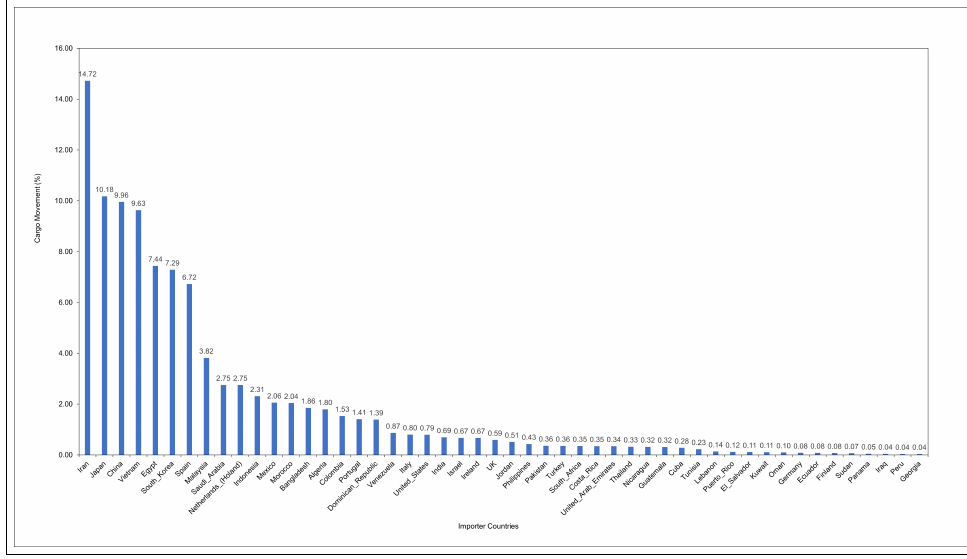
Figure 2. Importer countries by importance in cargo volume (%).